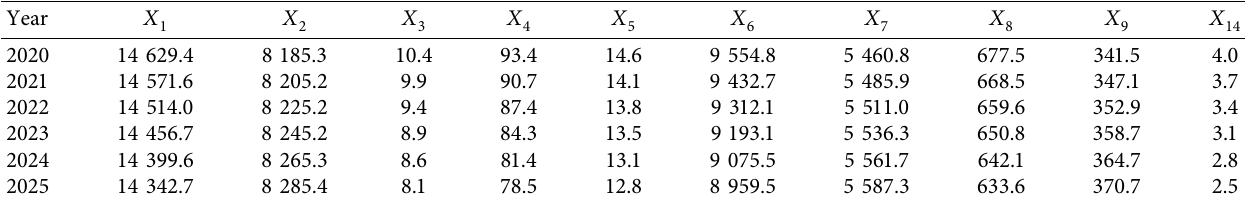
Table 4: Prediction of key impact factors for grain yield in Henan Province based on metabolism GM (1, 1) model.